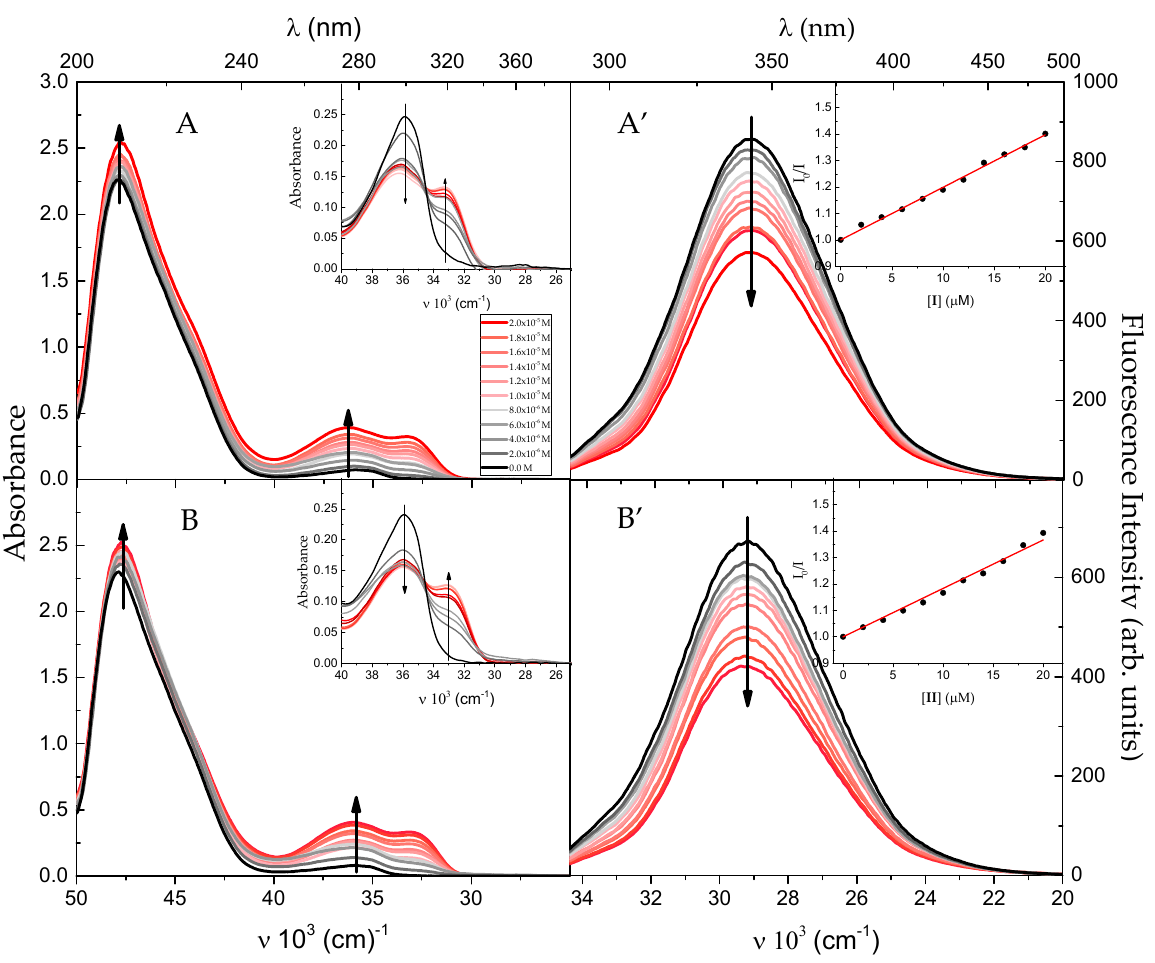
Figure 7. Absorption and fluorescence spectra ( λ exc. = 280 nm) of BSA (c = 2 × 10 − 6 M) in phosphate buffer solutions containing different concentration of I ( A , A’ ) and II ( B , B’ ) (0 M, 2.0 × 10 − 6 M, 4.0 × 10 − 6 M, 6.0 × 10 − 6 M, 8.0 × 10 − 6 M, 1.0 × 10 − 5 M, 1.2 × 10 − 5 M, 1.4 × 10 − 5 M, 1.6 × 10 − 5 M, 1.8 × 10 − 5 M, 2.0 × 10 − 5 M). The normalized LW absorption bands (by scaling the area under the spectrum to be equal to unity) are presented in insert of ( A , B ). The insert in ( A’ , B’ ) shows a graphical presentation of the relationship between I 0 /I versus (I) ( A’ ) and (II) ( B’ ). The interactions of BSA and Trp with two studied dyes were also investigated by the fluorescence quenching spectroscopy. In both cases (BSA and Trp), the addition of methyl benzoate derivative to a solution of BSA (or Trp) quenches significantly the single, broad fluorescence band centred at about 340 nm (BSA) and 352 nm (Trp) (registered upon excitation at 280 nm) without significant changes in the shape of the fluorescence spectrum (see Figures 7 and S3). There is no shift in the wavelength of maximum intensity of BSA and Trp when it was quenched by I and II . Using data obtained from the absorption and fluorescence titration experiments (BSA- investigated molecules and Trp-investigated molecules), the Benesi − Hildebrand plots were constructed (Figure S4). Since the plots of 1/ ( A − A 0 ) versus 1/ [ I ] (1/ [ II ] ) and 1/ ( I − I 0 ) versus 1/ [ I ] (1/ [ II ] ) produce a straight line for both systems with a good correlation coefficient (r > 0.95), the stoichiometry of the formed complexes between BSA (Trp) and methyl benzoate derivatives in the ground and excited states is 1:1. The binding constants were found to be (2.1 ± 0.1) × 10 4 M − 1 and (2.4 ± 0.1) × 10 4 M − 1 in the ground state and (2.0 ± 0.1) × 10 4 M − 1 and (2.7 ± 0.1) × 10 4 M − 1 in the excited state, for BSA- I and BSA- II , respectively and (2.0 ± 0.1) × 10 4 M − 1 and (2.2 ± 0.1) × 10 4 M − 1 in the ground state and (1.8 ± 0.1) × 10 4 M − 1 and (2.4 ± 0.1) × 10 4 M − 1 in the excited state, for Trp- I and Trp- II